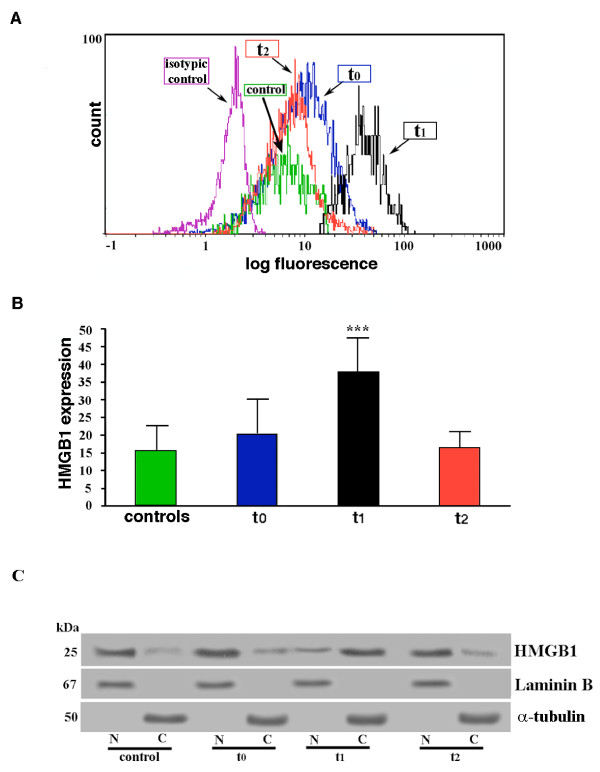
Analysis of HMGB1 cellular expression. (a) Flow cytometric analysis of HMGB1 expression in monocytes from one patient and one control subject (healthy donor). Mononuclear cells were drawn from the patients at three different times, that is, t0: before surgery, t1: immediately after surgical procedure; t2: at 24 hours following intervention. Cells were stained with polyclonal anti-human HMGB1 1 μg/ml (Abcam) for one hour at room temperature. Nonspecific binding was determined by an unlabeled isotypic control antibody (Coulter-Immunotech, Hamburg, Germany). After washing with cold PBS, cells were incubated with FITC-conjugated anti-rabbit IgG and then analyzed by flow cytometry. Antibody reactivity was reported as mean fluorescence intensity. Histograms show the log fluorescence versus the cell number. (b) Results of flow cytometric analysis of HMGB1 expression in monocytes from controls (healthy donors) and from the patients under test at three different times: t0 = before surgery, t1 = immediately after surgical procedure; t2 = at 24 hours following intervention. Mean fluorescence intensities were measured and plotted values represent mean ± SD. ***t1 vs t0, t1 vs t2: P < 0.0001. (c) Monocytes cells were sampled at the indicated time points and subjected to nuclear (N) and cytoplasmic (C) fractionation. The levels of endogenous HMGB1 in the nuclear and cytoplasmic fractions were determined by immunoblotting with anti-HMGB1 antibodies. Laminin B served as nuclear contamination marker and α-tubulin as cytoplasmic contamination marker. Protein loading within each compartment was also normalized with Laminin B and α-tubulin, respectively.